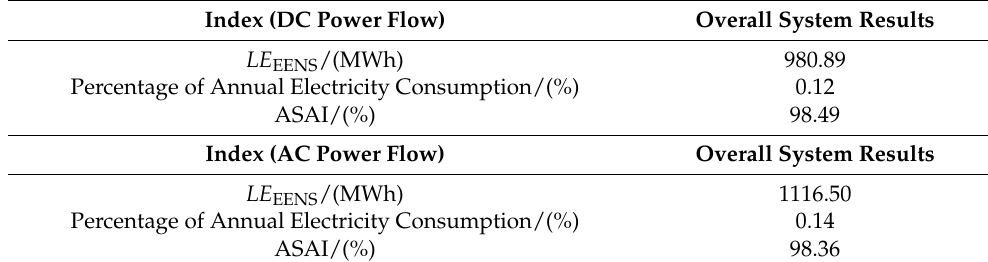
Table 6. System reliability index.